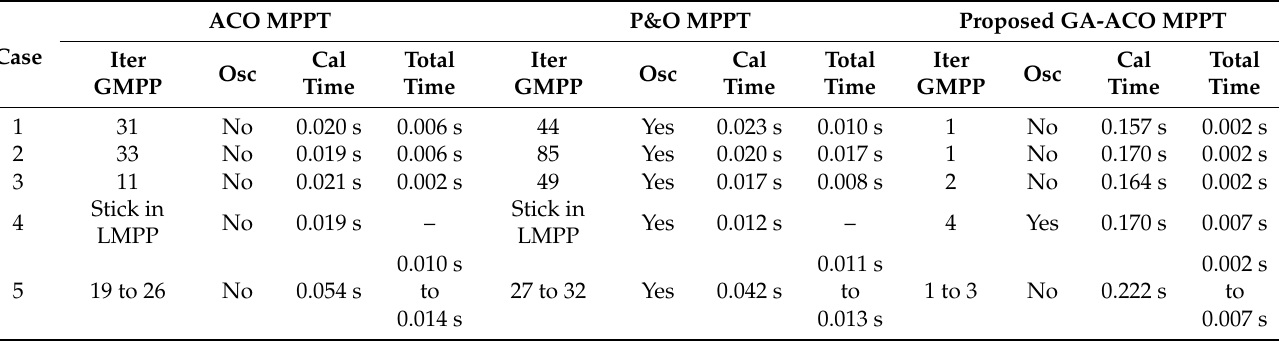
Table 5. The performance conclusion